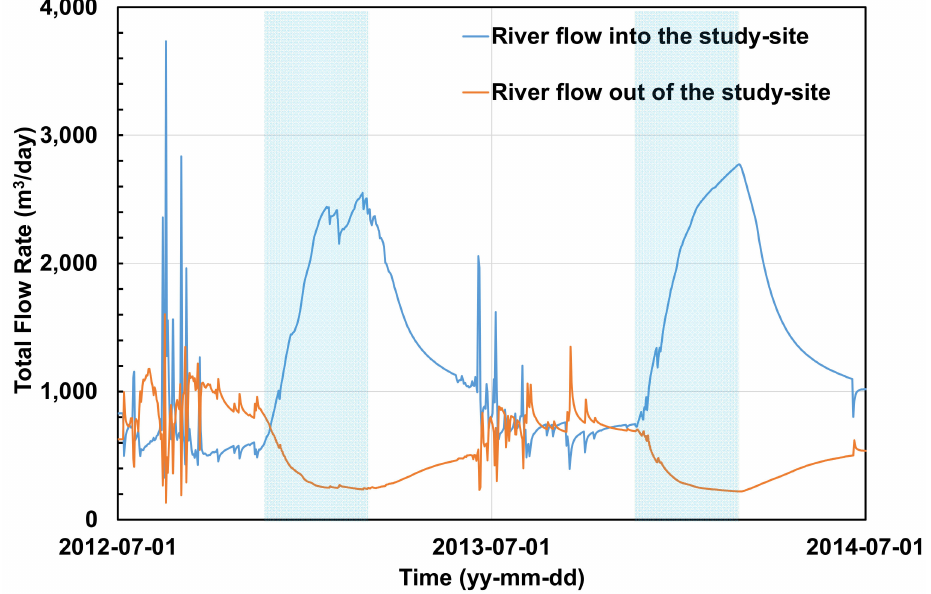
Figure 6. Temporal changes of water budget of the Mushimcheon river owing to the seasonal water use in the study-site (blue shaded boxes represent WCC